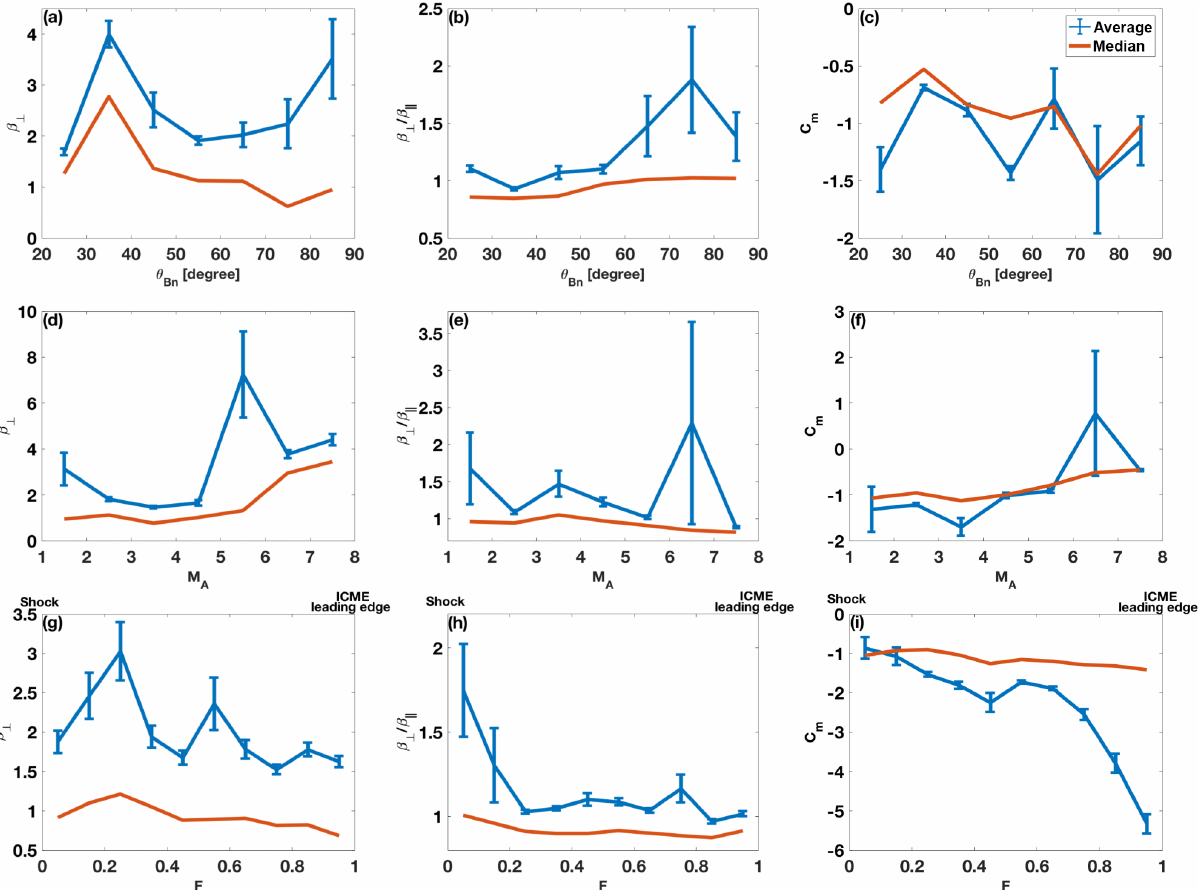
Figure 9. Average and median β ⊥ , β ⊥ /β (cid:107) and C m (see panel c for color codes) in the near-shock sub-region as functions of θ Bn (a–c) and M A (d–f) in bins of 10 ◦ and unity, respectively. (g–i) Show the plasma parameters as a function of F in bins of 0.1. Due to low statistics, the sheaths whose shock had 0 ◦ < θ Bn < 20 ◦ are omitted in panels (a–c) and the ones whose shock had M A > 8 are omitted in panels (d–f) (see Fig. 7). The error bars are defined by